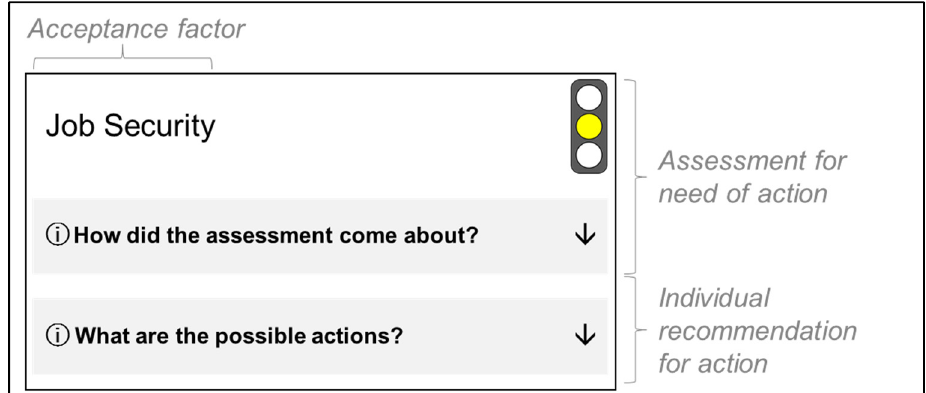
Figure 3. Example for the assessment of need for action in phase 2.